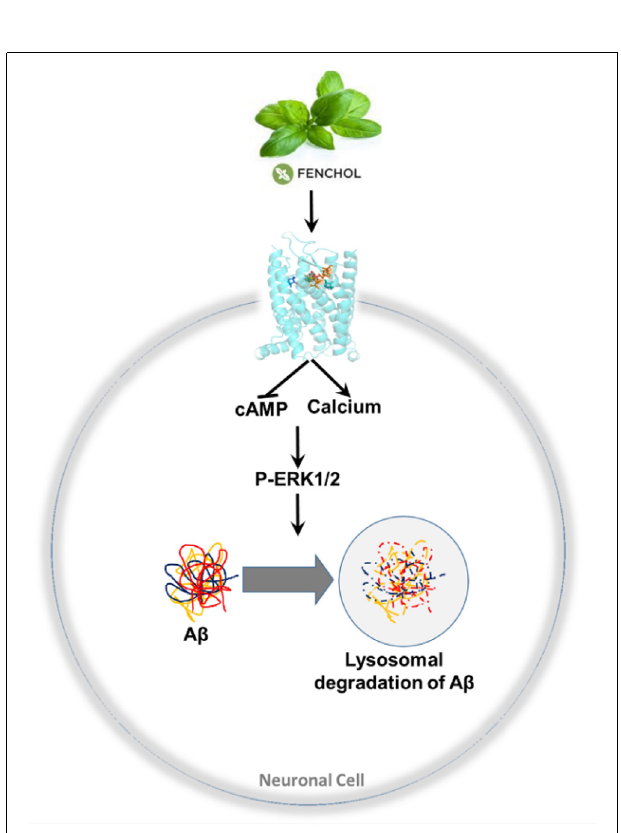
FIGURE 7 | A purported model of findings in this study. Fenchol (commonly present in basil plant/leaves) activates FFAR2 signaling by increasing intracellular calcium and reducing cAMP, thus activating pERK1/2 phosphorylation, which in turn increases A β clearance by activating lysosomal degradation in neuronal cells. These results indicate that the activation of FFAR2 by Fenchol reduces AD-like pathology in